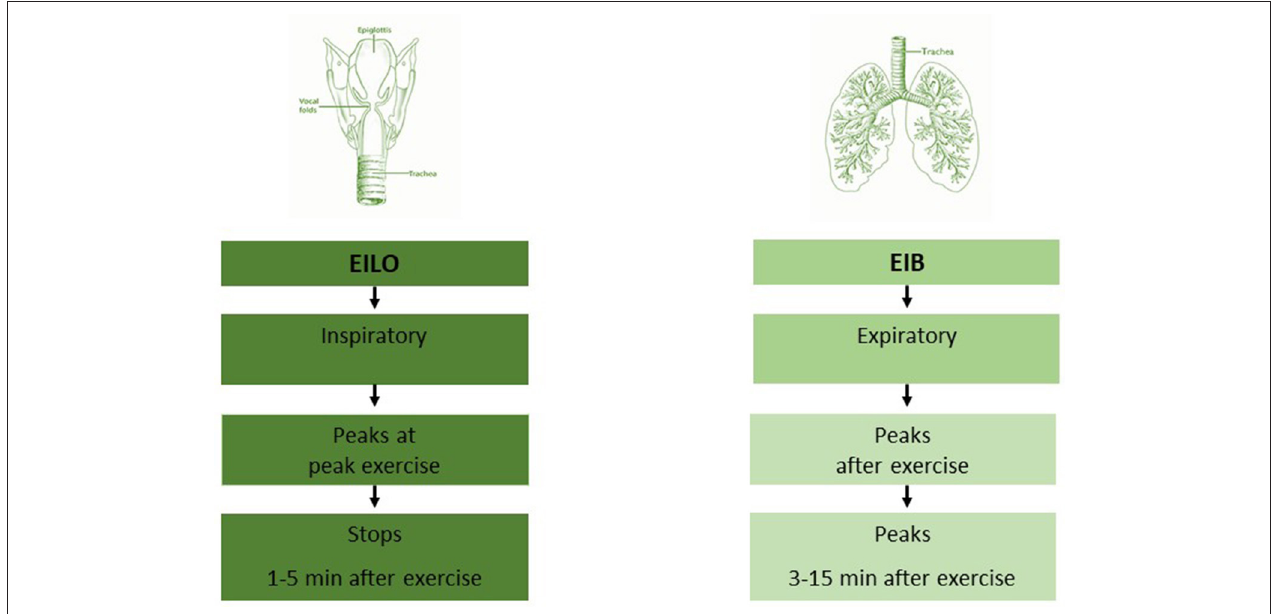
FIGURE 1 | Work-up should be customized to the level of complaints, but always involve a thorough symptom description. Spirometry, and a standardized exercise test for *exercise induced bronchoconstriction (EIB) are logical second steps. The EIB test should always include the test-leaders thorough description of breathing patterns during and after the test, and a patient verification that the symptoms perceived during the test were similar to those that in-cited the work-up. Patients with classical symptoms of EILO observed during an exercise test may not need a CLE test, depending on the clinical situation. Persistent symptoms without findings must incite further work-up. **Diagnostic tests for BHR might include Spirometry with reversibility, PD20, EVH, Mannitol or hypertonic saline, depending on the clinical situation and department policy. EIB, exercise induced bronchoconstriction; EILO, exercise induced laryngeal obstruction; BHR, bronchial hyperresponsiveness; CLE, continuous laryngoscopy exercise test; CPET, cardiopulmonary exercise test. Modified from Paediatric Respiratory reviews